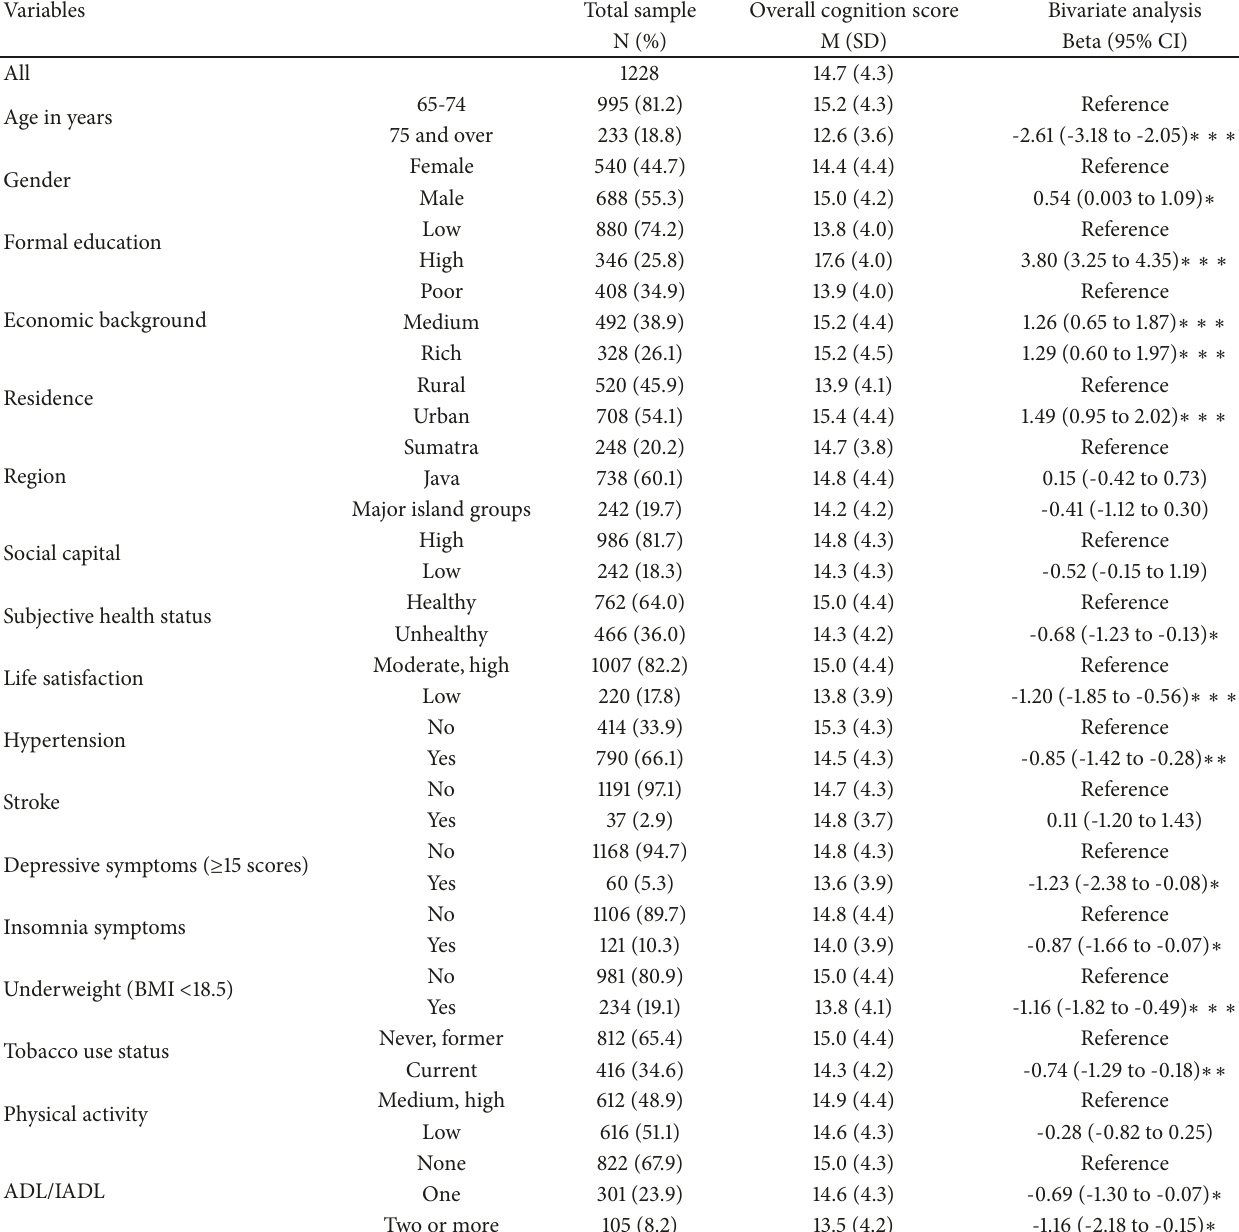
Table 1: Sample characteristics and prevalence of cognitive functioning among older adults in